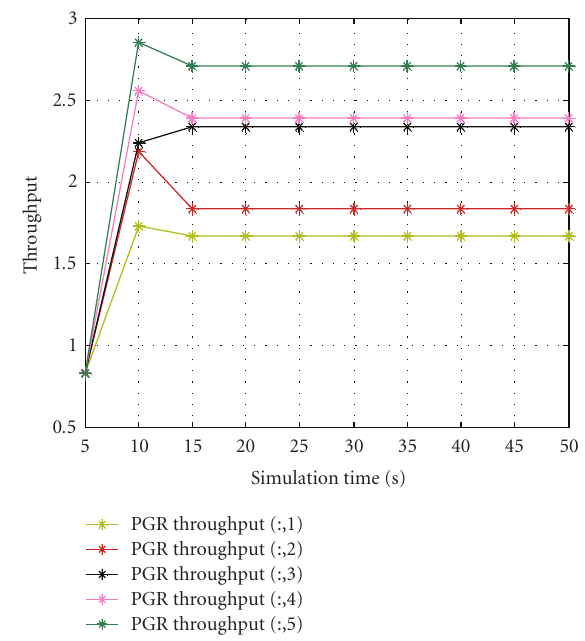
Figure 7: Simulation time and success rate.